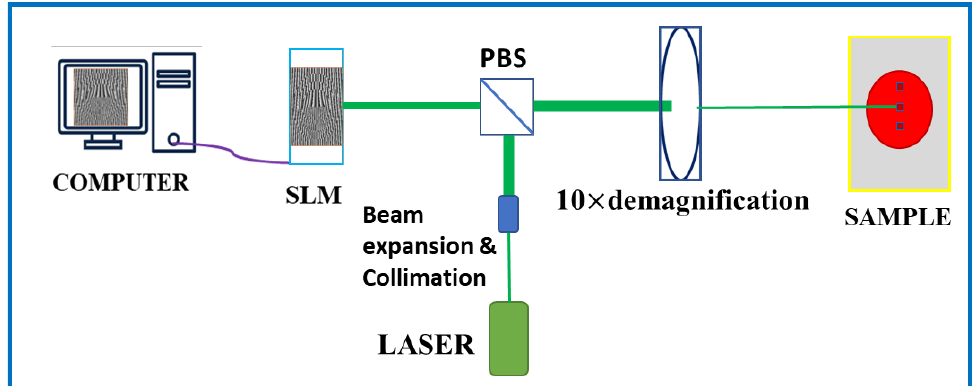
Figure 7. Schematic of optical setup for digital hologram printing on azocarbazole polymer film.